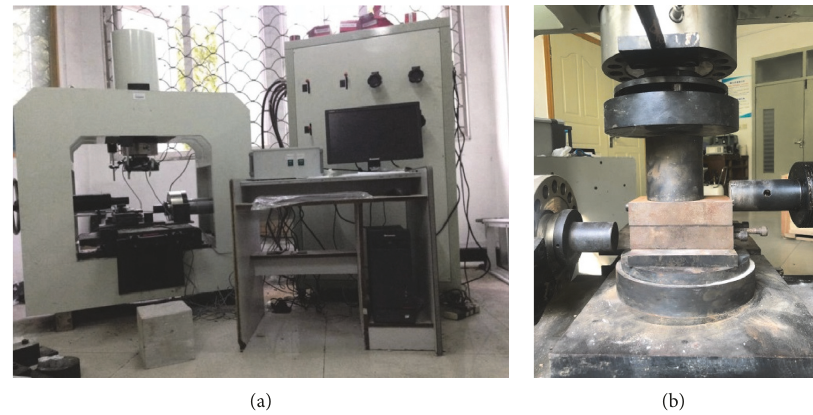
Figure 3: Shear test device: (a) YZW1000 computerized direct shear testing device; (b) shear loading device.